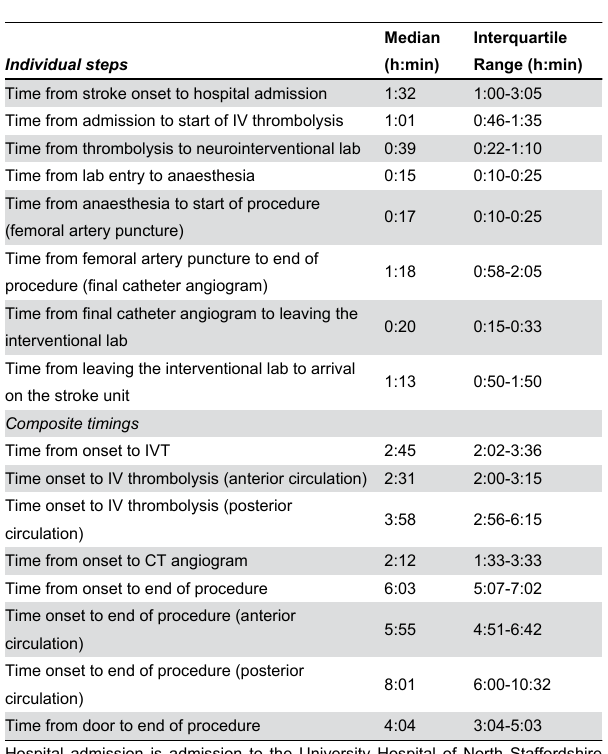
Table 2. Timings for steps in the EVT pathway.